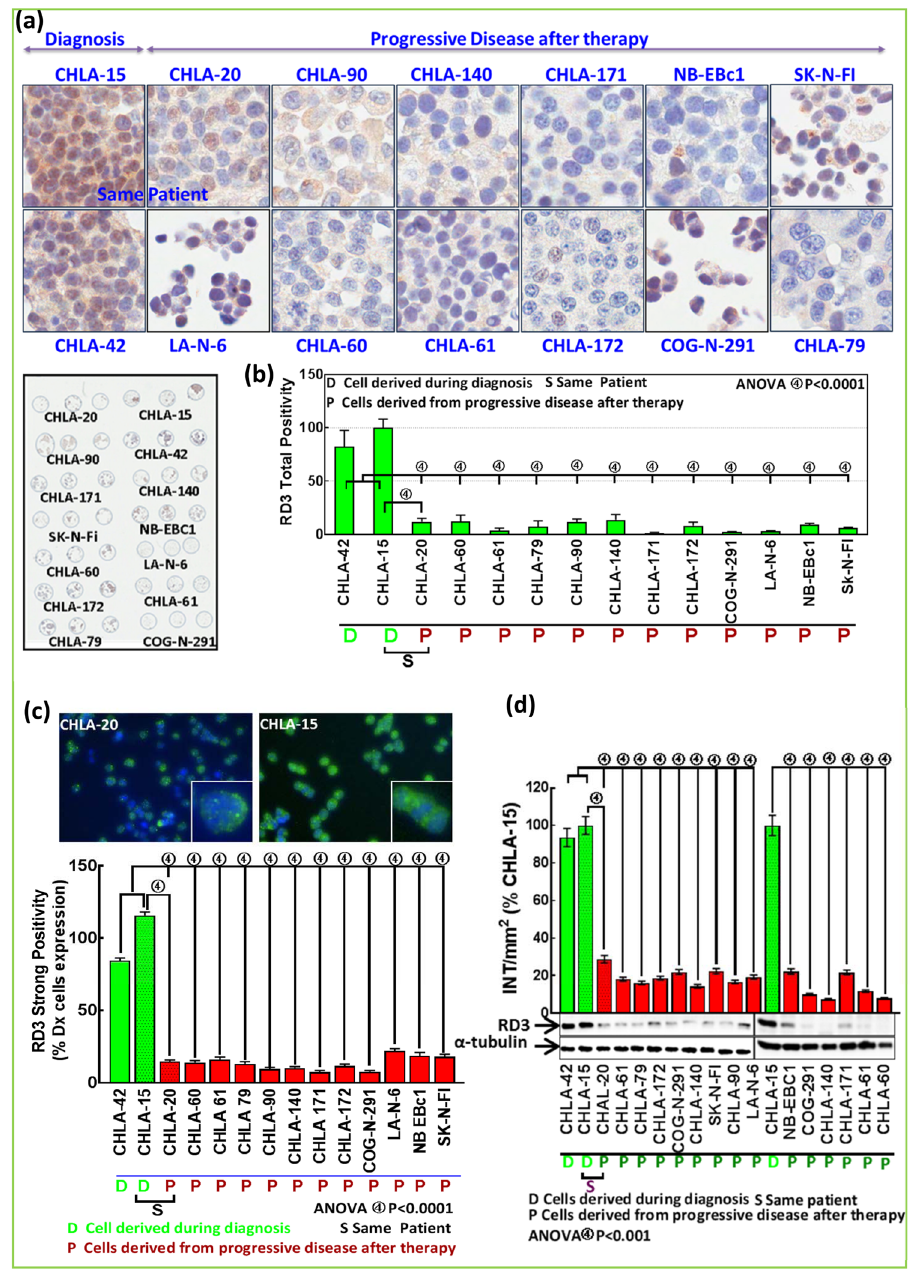
Figure 2. Acquired loss of RD3 protein with IMCT: ( a ) Representative microphotographs of RD3-immunostained MYCN-na NB cells showing expression and localization disparities of RD3 between cell lines derived at diagnosis vs . progressive disease (PD). Lower Panel . Custom-archived CMA with the panel of 14 MYCN-na NB cell lines. ( b ). Histograms from Aperio CMA image analysis and quantification for RD3 total positivity showing abundant positivity in diagnosis cell lines, but weak and less abundant RD3 positivity in cell lines from PD after IMCT. ( c ) Representative microphotographs from high-content confocal microscopy showing RD3 localization and expression in CHLA-15 (Dx) and CHLA-20 (PD) cells. Bottom Panel . Histograms obtained from Columbus quantitative image analysis showing strong and abundant RD3 positivity in two diagnosis-derived cell lines and low abundance and weak positivity of RD3 in 12 PD (after IMCT) cell lines. ( d ) Representative immunoblots and histograms from band intensity analysis showing acquisition of significant RD3 loss in PD cell lines compared with those derived during diagnosis. Full-length blots are presented in Supplementary Fig.